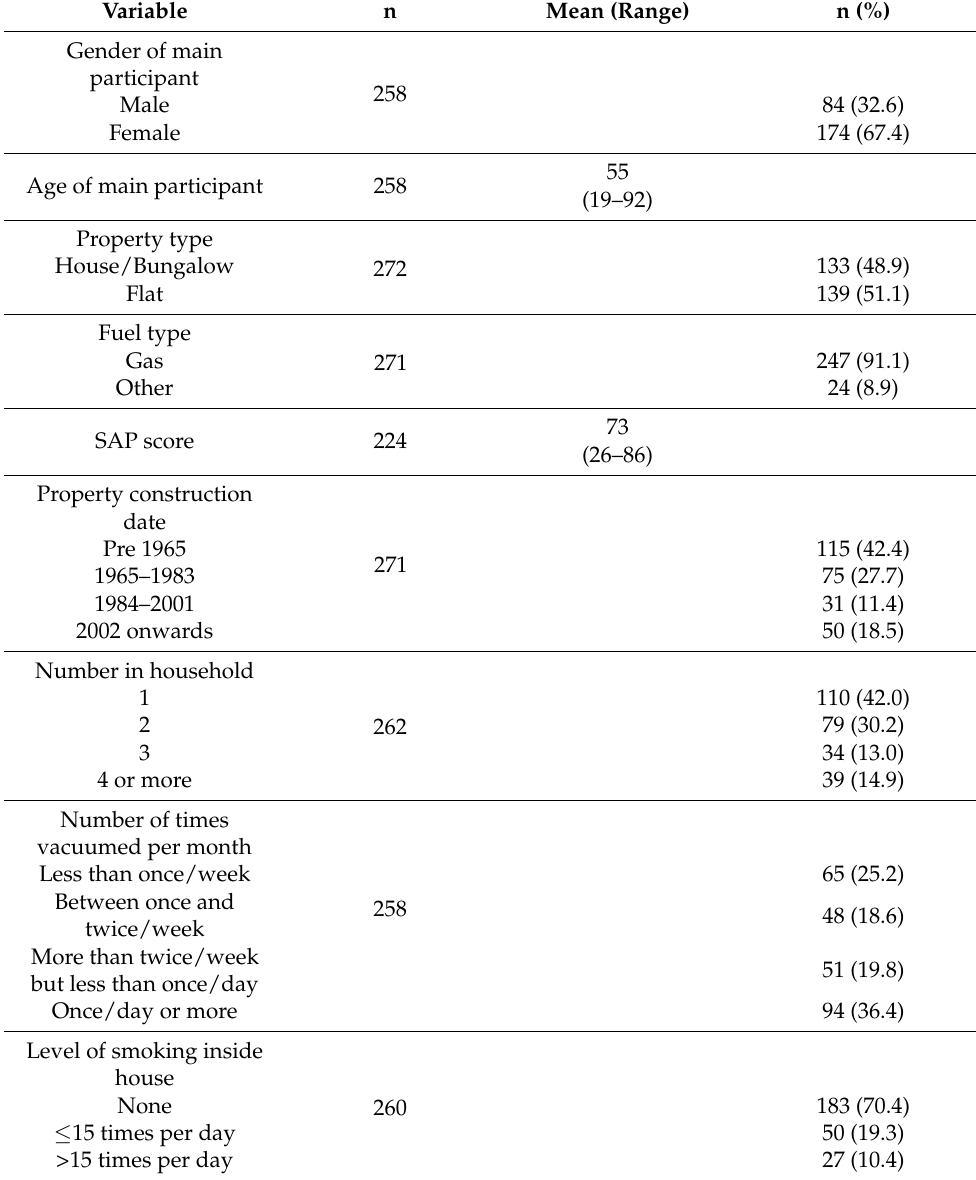
Table 2. Baseline characteristics of participants and their properties (n =